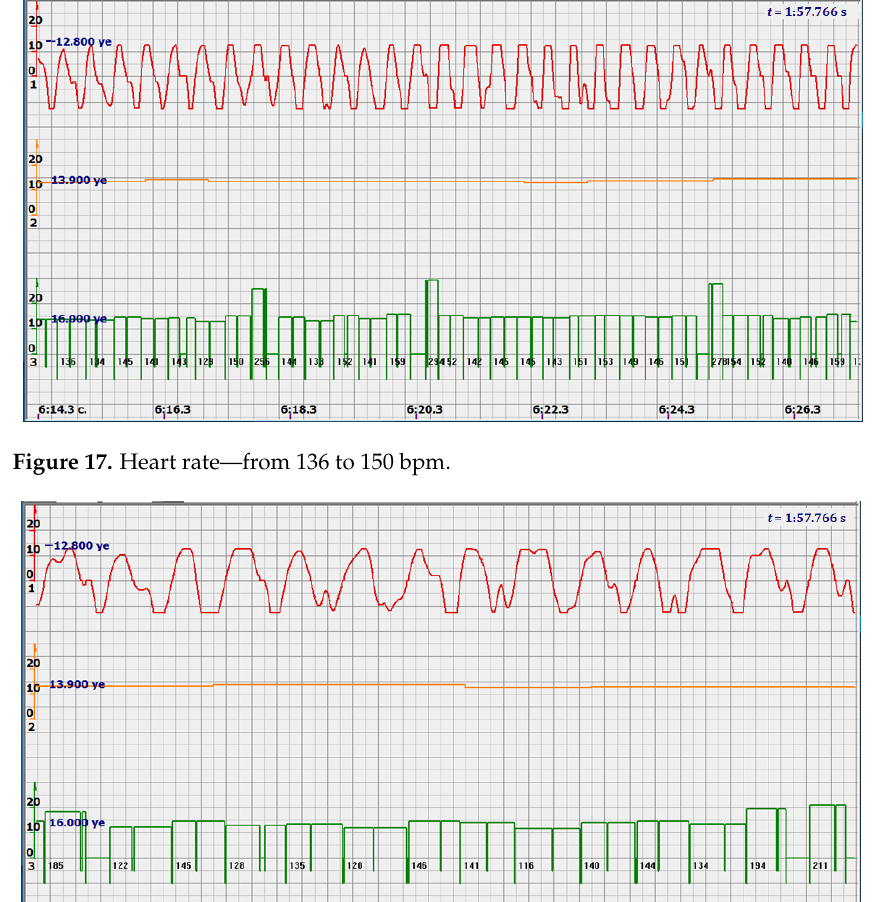
Figure 16. Heart rate—from 122 to 146 bpm.